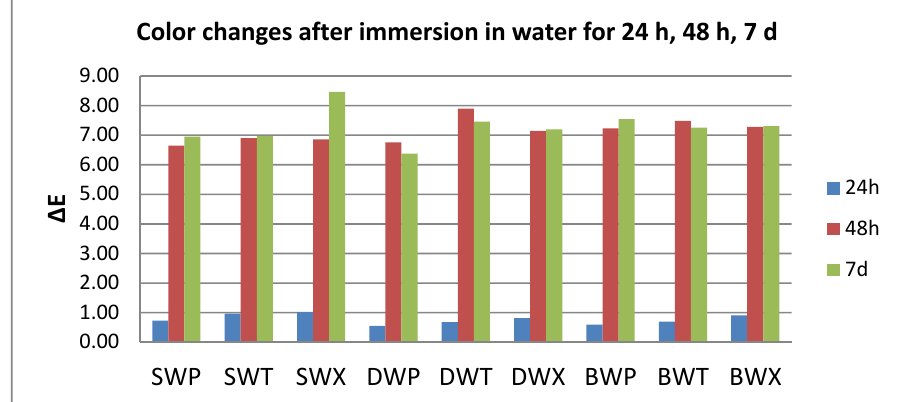
Figure 5. Mean values for ∆ E parameter for all the tested values after immersion in distilled water.